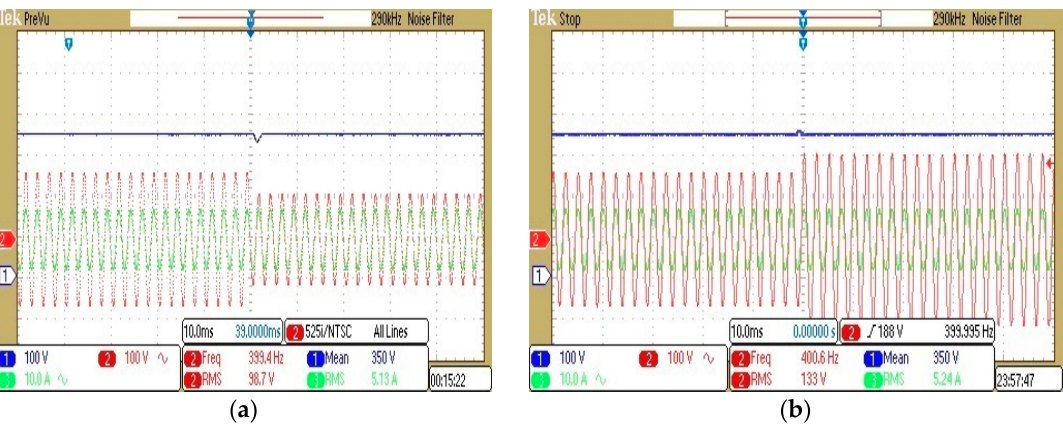
Figure 20. The output dc voltage, input voltage and current waveform underthe input voltagetransient variation by the MPDPC with the Bayesian estimation. ( a ) The waveform during input voltage drop; ( b ) The waveform during input voltage swell.